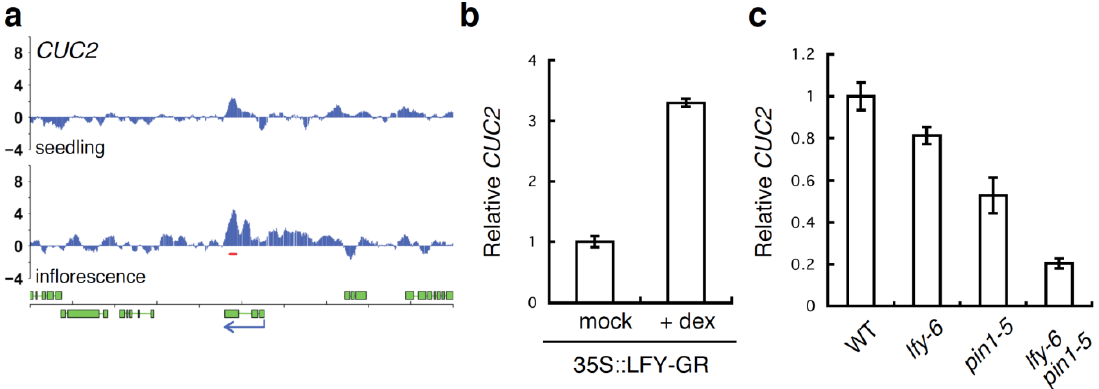
Figure 4. LFY regulates CUC2 gene expression. ( a ) LFY binds to the regulatory regions of CUC2 gene based on a published ChIP-chip data set [37]. Screenshots of the binding peaks (blue vertical lines). Significant LFY-binding peaks are indicated by a red horizontal line below the peaks. Green boxes below the graphs denote exons, blue arrows indicate the direction of transcription; ( b ) Expression of the CUC2 gene based on qRT-PCR three hours after mock or dexamethasone (dex) treatment of lfy-6 35S::LFY-GR inflorescences; ( c ) Expression of the CUC2 gene based on qRT-PCR in lfy-6 null mutant, the weak pin1-5 mutant, and pin1-5 lfy-6 double mutant inflorescence apices compared to wild-type inflorescence apices. RNA from floral bud clusters (containing stages 1–6 flowers) was used in this